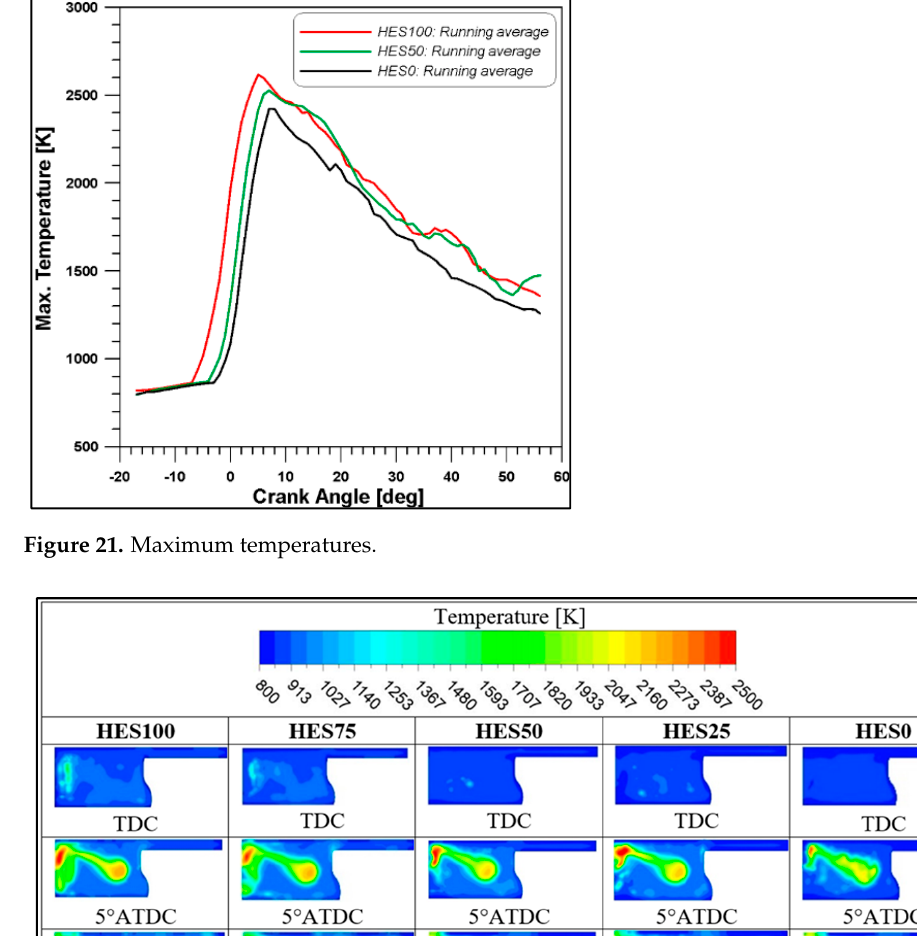
Figure 20. Diesel mass fraction.